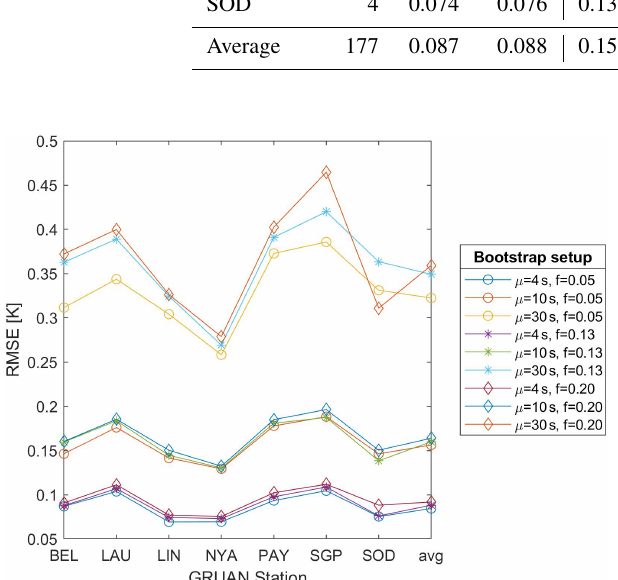
Figure 7. Linear interpolation uncertainty by GRUAN site and aver- age gap size µ G = 4, 10, and 30s. The cross-validation uncertainty ( y axis) is based on the root mean square error (RMSE) for missing fractions f = 0 . 05, 0.13, and